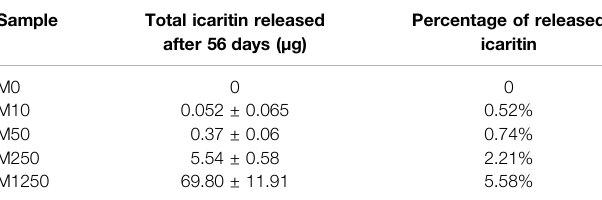
TABLE 2| Thequantitiesoftotal(cumulative)released andremainingicaritin inthe samples after 56 days soaking.